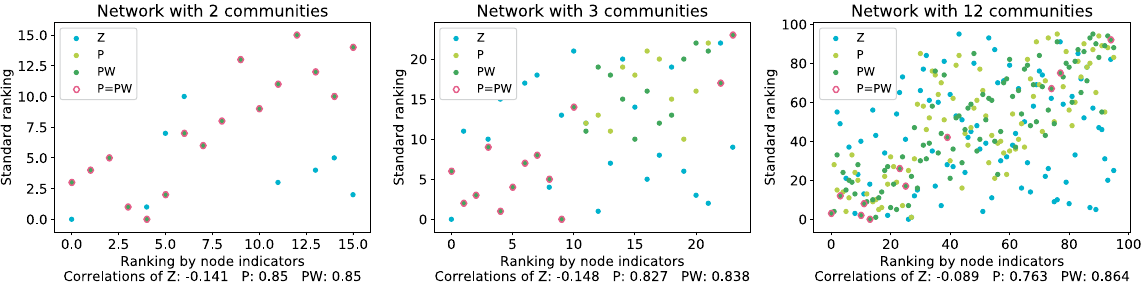
Figure 7. Rank correlations by path length and node indicators. The vertical axis represents the standard node ranking sorted by the average shortest path length after the attack, and the horizontal axis represents the node ranking ordered by the indexes Z, P and PW. Nodes with the same rankings in P and PW are indicated by red circles around green dots. We used RC networks with 2, 3, and 12 communities having 16, 24, and 96 nodes and 56, 84, and 336 edges, respectively, from left to right, with the Spearman’s rank correlations between standard node rankings and the rankings by the indexes.